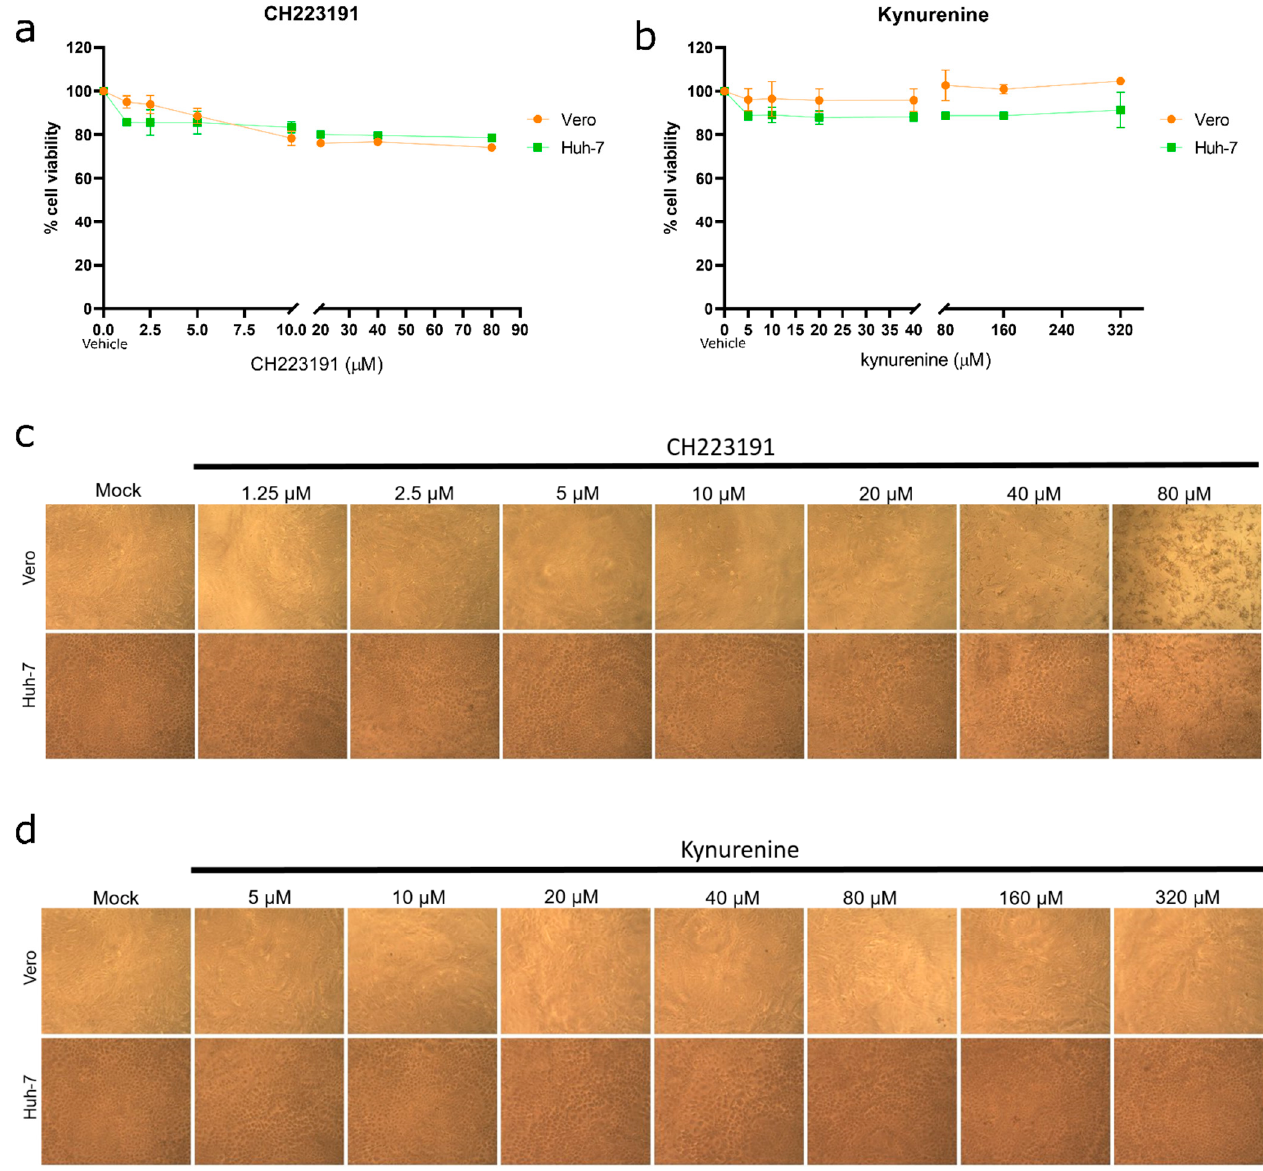
Figure 2. Compound cytotoxicity determination. Cell cultures were exposed to different concentra- tions of either CH223191 ( a , c ) or kynurenine ( b , d ) for 72 h. Afterward, viability determination of treated cells was performed by MTT assay ( a , b ). Mock: cells treated with vehicle. Bars represent mean ± SD. Light microscopy observations of cell cultures were performed at 72 h of exposition to both compounds ( c , d ). Magnification: 100×.